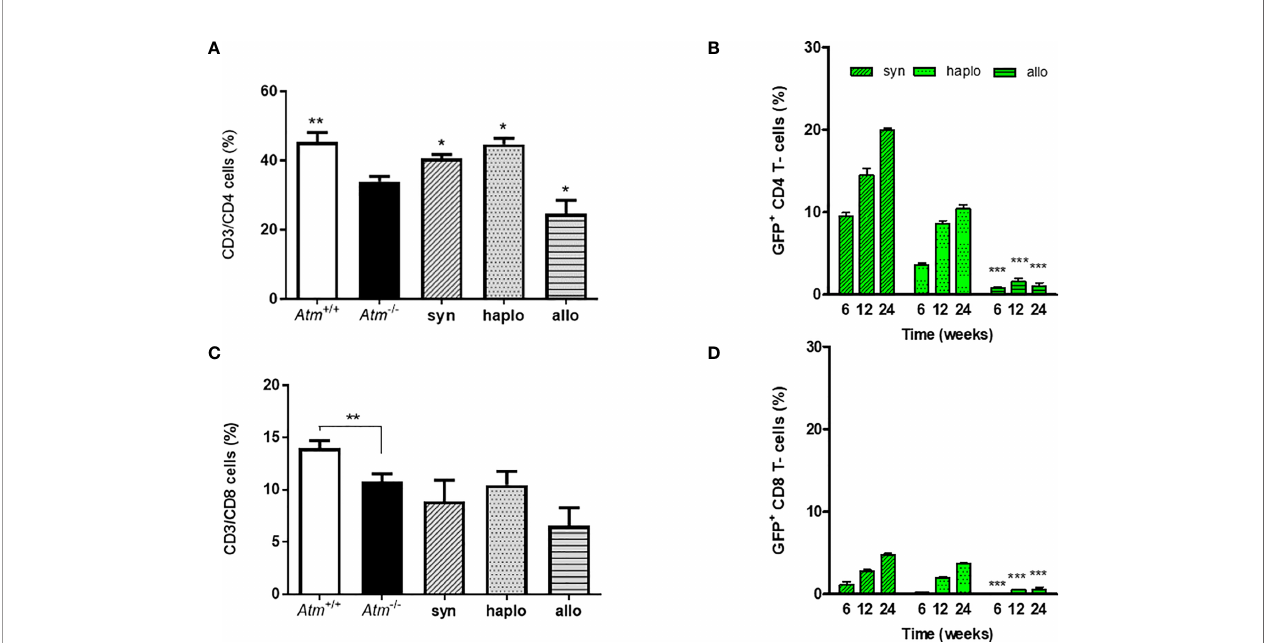
FIGURE 3 | Phenotypic analysis of wild-type and Atm -de fi cient mice before HSCT and long-term engraftment of GFP expressing donor cells in Atm -de fi cient mice after syngeneic, haploidentical and allogeneic HSCT in peripheral blood samples. (A, B) Percentage of CD4 + and CD8 + lymphocytes in Atm -/- (n = 8) compared to Atm +/+ mice (n = 8) as well as in syngeneic (n = 4), haploidentical (n = 4) and allogeneic (n = 4) transplanted Atm -/- 24 weeks post transplantation. (C, D) Analysis of the engraftment of GFP + cells derived from syngeneic, haploidentical and allogeneic donor mice in peripheral blood samples of Atm -/- recipient mice (n = ≥ 5) and surface stained for CD4 + and CD8 + at timepoints 6, 12 and 24 weeks post HSCT (* only compared to syngeneic). Data are presented as mean ± SEM. * p < 0.05, ** p < 0.01, *** p < 0.001. GFP, green fl uorescent protein; HSCT, hematopoietic stem cell